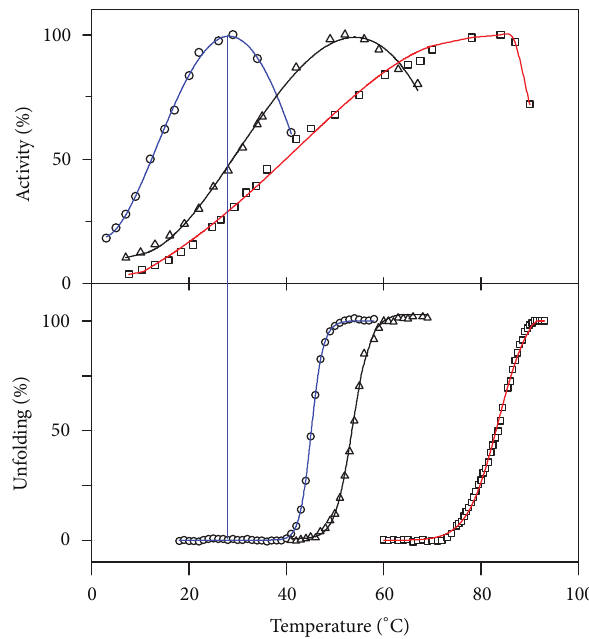
F 5: Inactivation and unfolding of psychrophilic enzymes. e activity of most psychrophilic enzymes (upper panel, blue curve) is inactivated by temperature before unfolding of the protein structure (lower panel) illustrating the pronounced heat lability of the active site. By contrast, inactivation of mesophilic (black curves) or thermophilic (red curves) enzymes closely corresponds to the beginning of protein unfolding. Adapted from